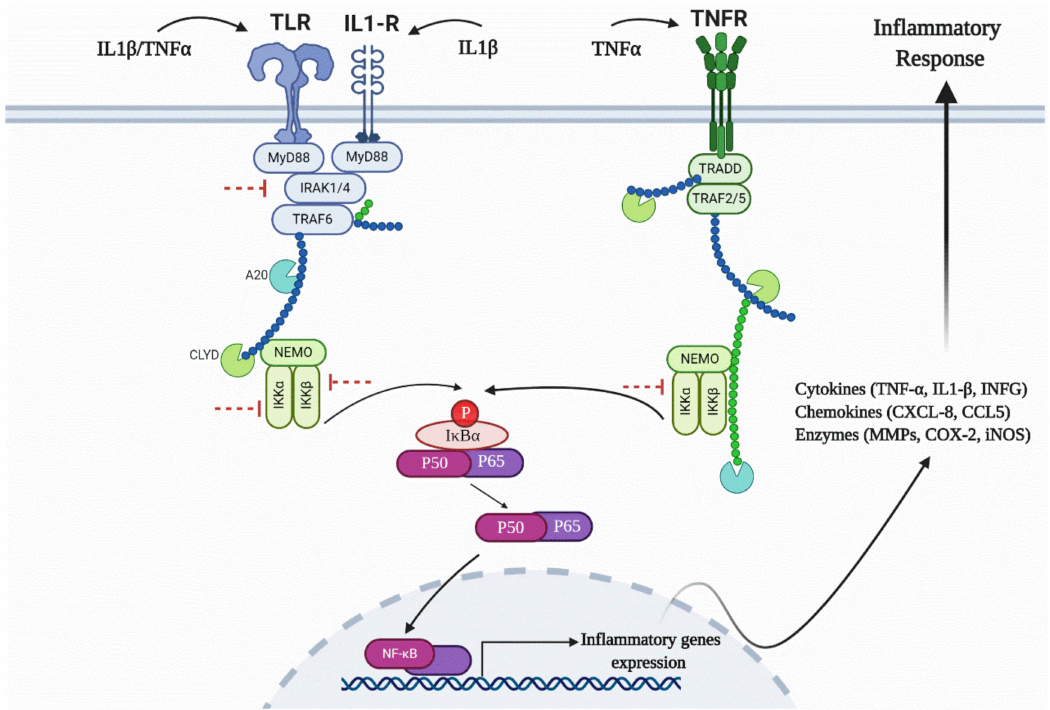
Figure 11. Schematic figure of the NF- κ B signaling pathway and inhibition of IKK complex after treatment with VA. The red inhibitor arrows show the predicted inhibitory e ff ect of VA in di ff erent parts of the